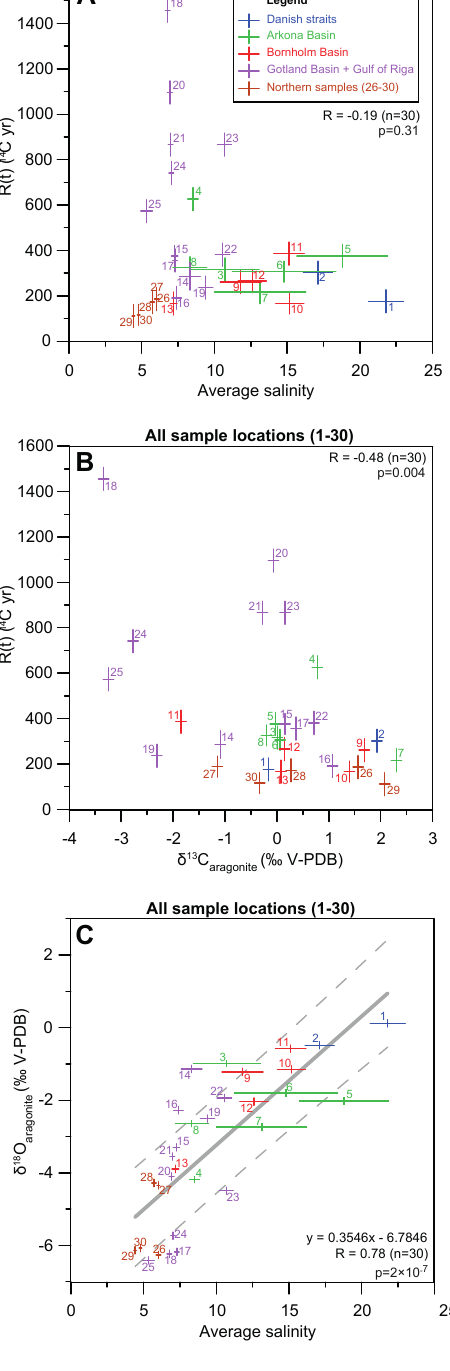
Fig. 3. (A) R(t) vs. average salinity for all samples. 1 σ error bars. (B) R(t) vs. δ 13 C aragonite for all samples. 1 σ error bars. (C) δ 18 O aragonite vs. average salinity for all samples. 1 σ error bars. Linear regression (grey line) with 1 σ confidence intervals (dashed line) also shown. For all figures: numbers next to data points indi- cate sample location numbers following Fig. 1 and Table